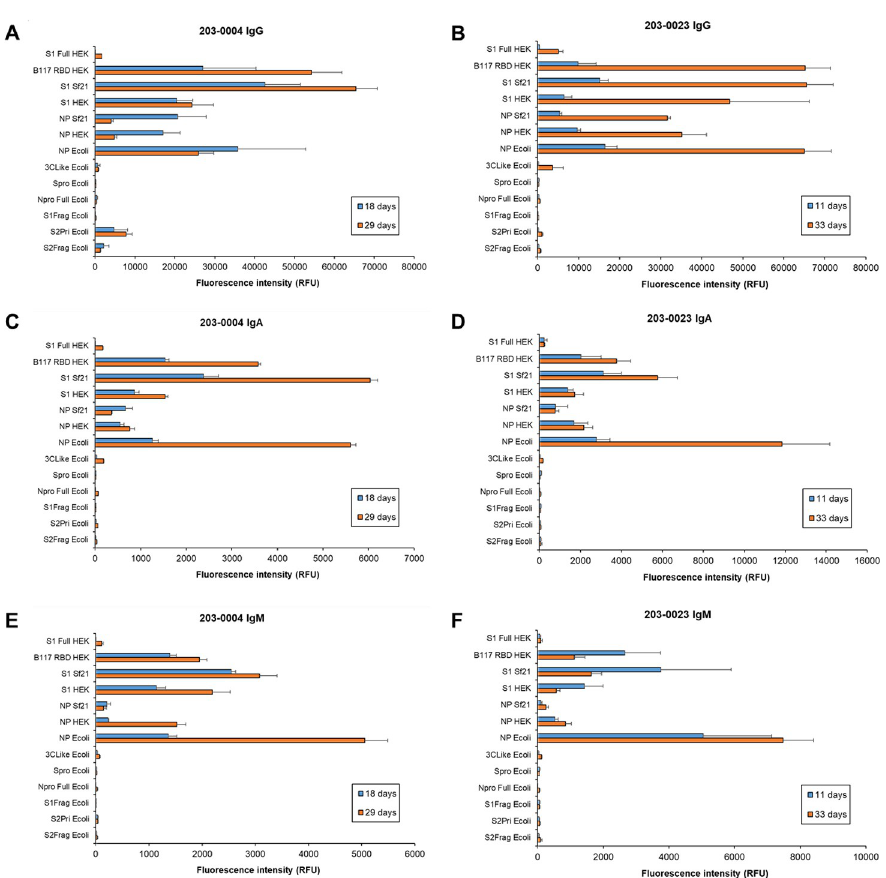
Fig 6. Dynamic binding of patient serum antibody isotypes over short to medium term for severe COVID-19 disease. Bar charts represent binding intensity data for serum (A,B) IgG, (C,D) IgA, and (E,F) IgM binding to SARS-CoV-2 antigens for patient 203–0004 ( A,C,D ; M, 42 years) and 203–0023 ( B,D,F ; F, 56 years) at 18 and 29 days, and 11 and 33 days post-first symptom onset, respectively. Bars represent the average binding intensity from three replicate experiments with error bars of +/- one standard deviation